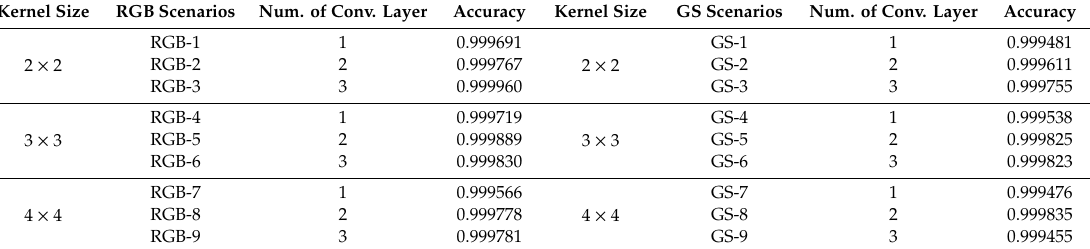
Table 9. Comparison of Accuracy by Number of Convolution Layers in multiclass classification in case of KDD.